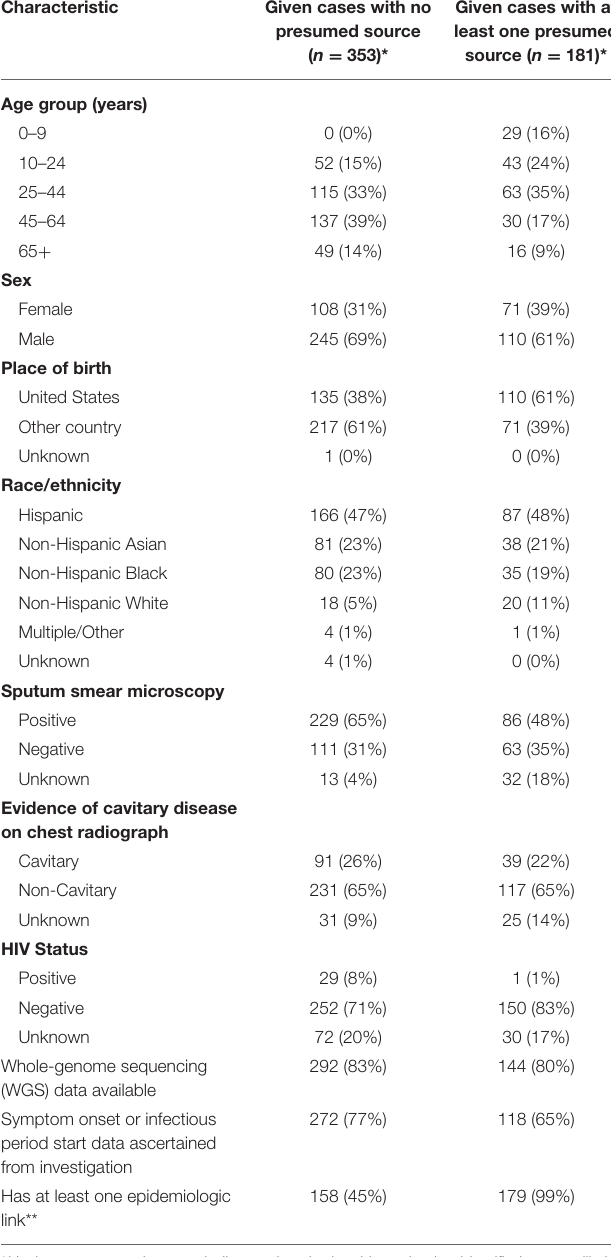
TABLE 2 | Select demographic and clinical characteristics of 534 tuberculosis cases in 56 clusters – California, Los Angeles County, and New York City,